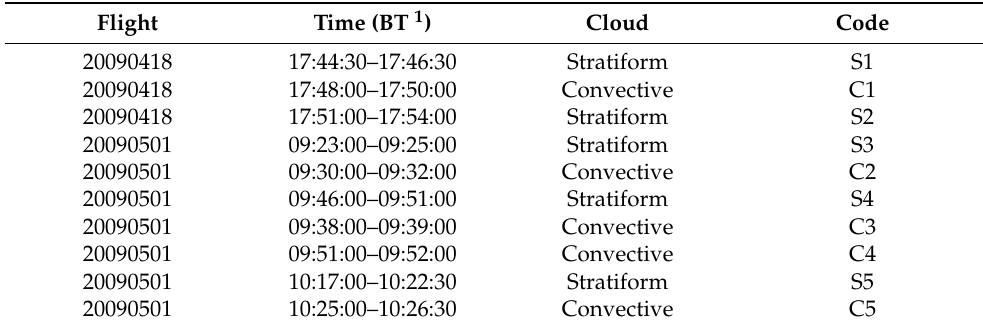
Table 1. The identified cloud regions in the selected